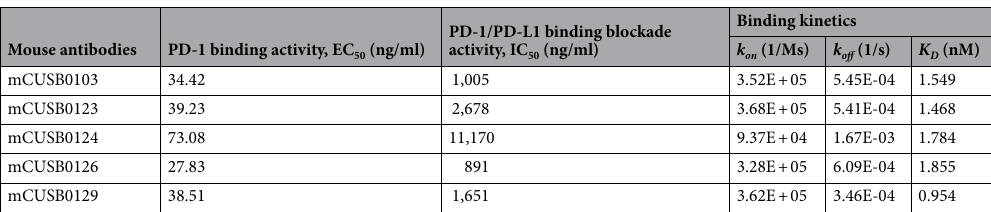
Table 1. Functional properties of mouse anti-PD-1 monoclonal antibodies.